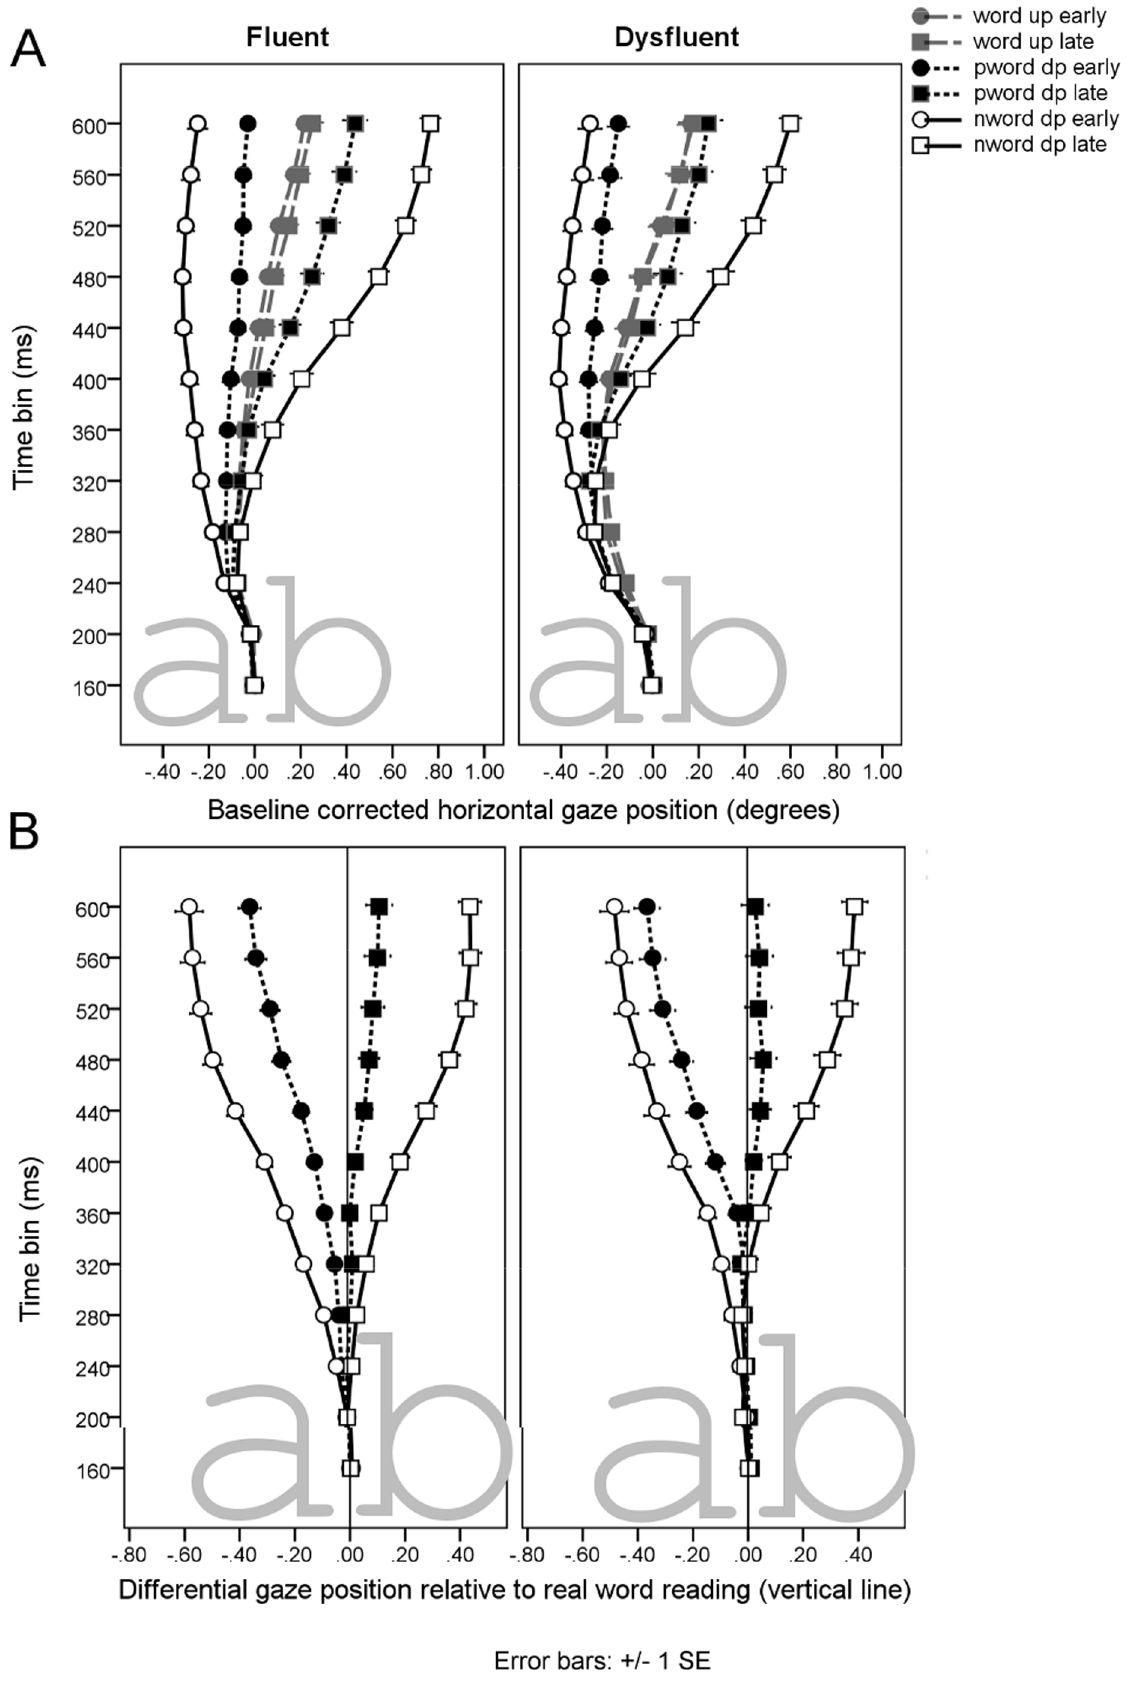
Figure 6. Gaze position data. Upper panels (A) illustrate baseline-corrected data and lower panels (B) illustrate differential real word minus pseudo- and nonword data. doi:10.1371/journal.pone.0108937.g006 PLOS ONE |